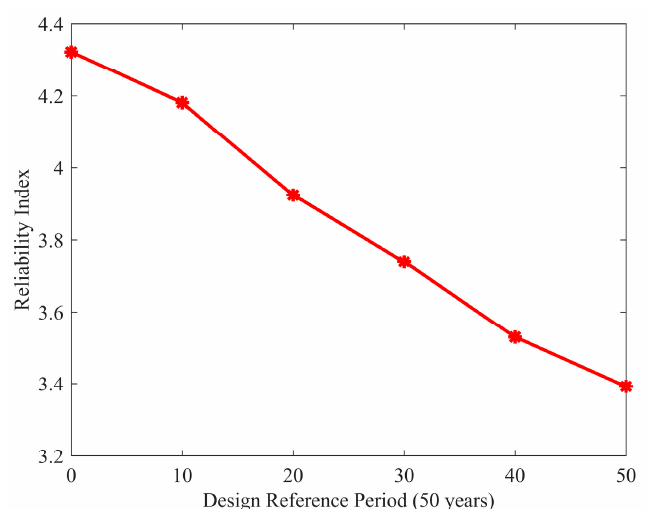
Figure 5. Time-varying reliability index of the in-service transmission tower.